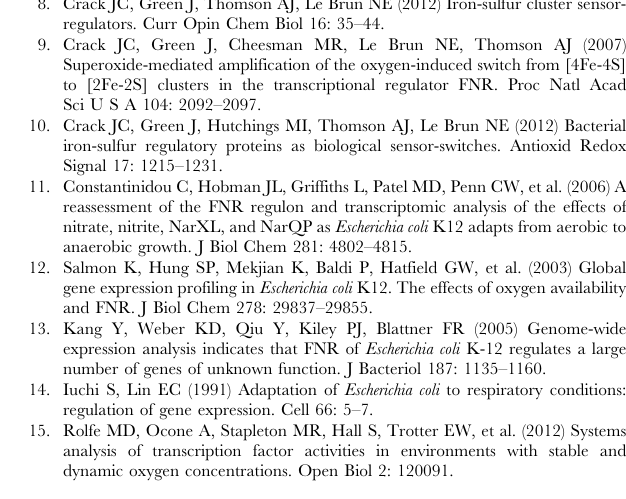
Table S1 Agent description for the O 2 molecule. (DOCX) Text S1 Additional description of interaction rules for the regulatory systems, ArcBA and